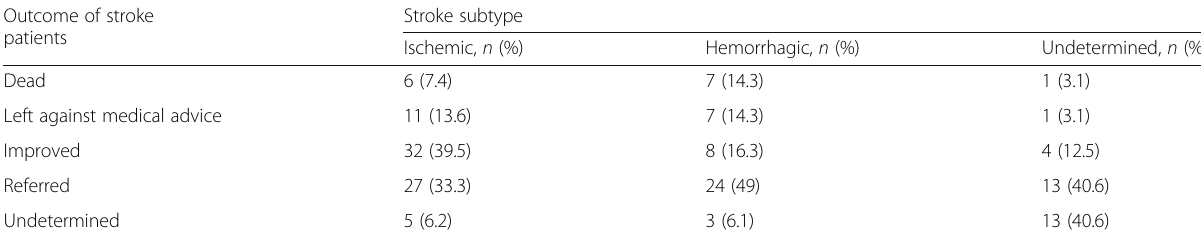
Table 5 Outcomes of patients with stroke subtype admitted in the medical ward of Debre Markos Referral Hospital, Northwest Ethiopia, 2017 – 2019 Outcome of stroke